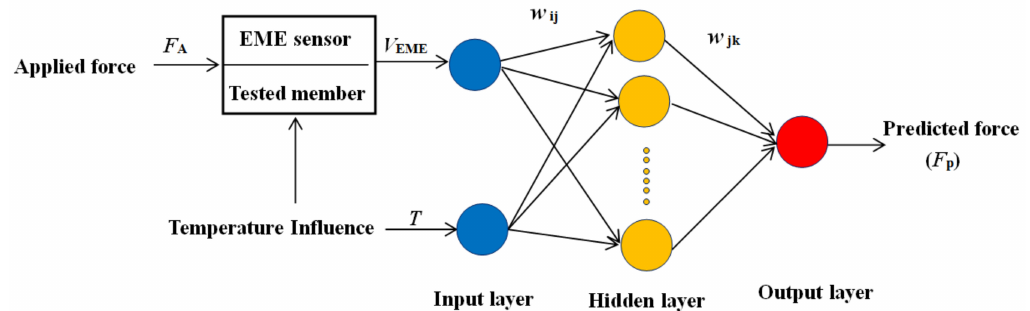
Figure 6. Structure of the BP neural network for